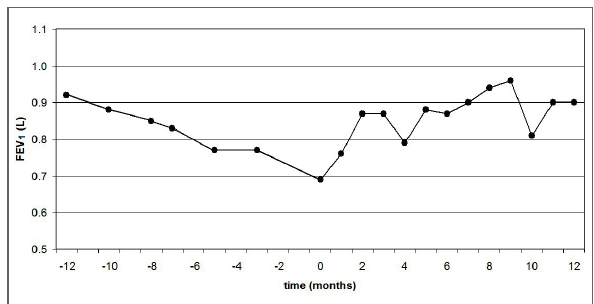
Fig. 2. Change in FEV